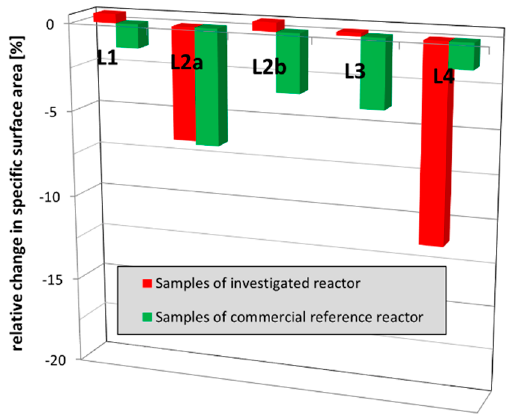
Figure 8. Comparison of the relative changes in specific surface area of used catalyst samples from the investigated reactor and the commercial reference reactor. The samples of each layer were averaged.